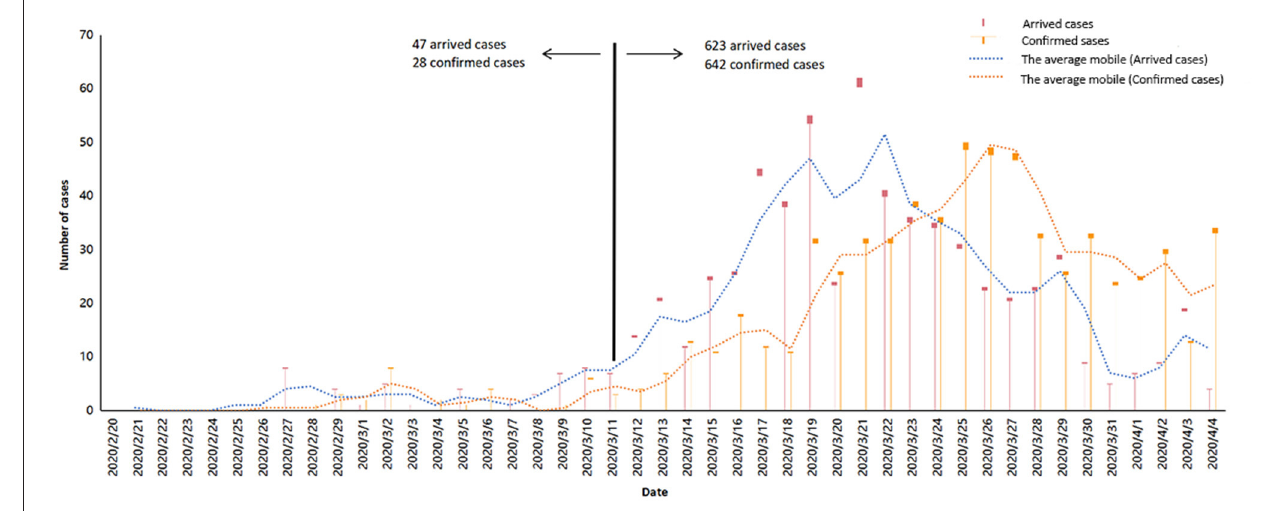
FIGURE 4 | Time distribution of confirmed cases from abroad.